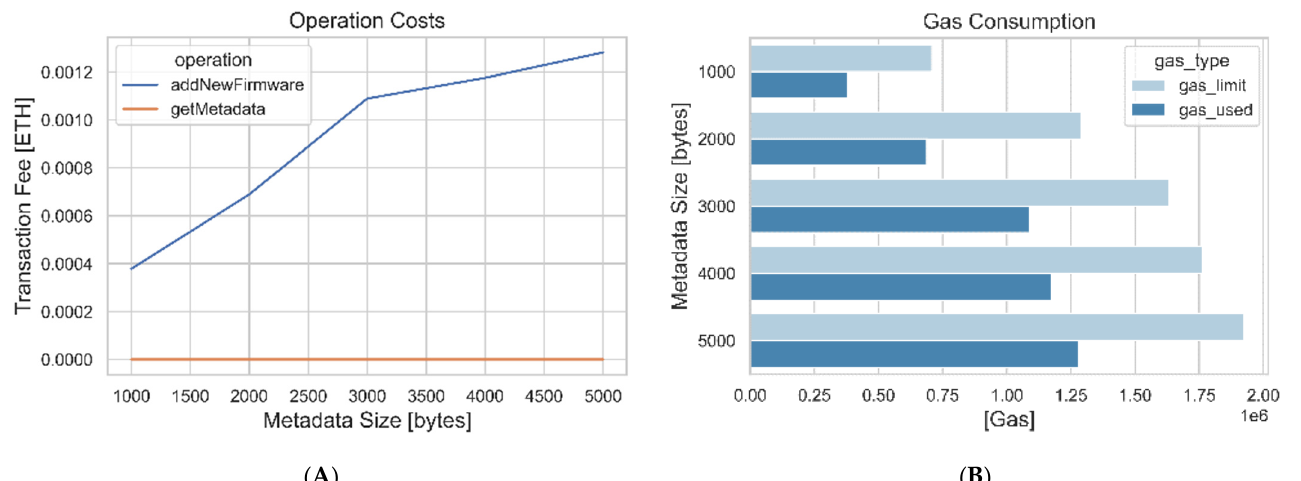
Figure 18. ( A ) Gas Price in ether. ( B ) Gas consumption of adding new firmware metadata on the Blockchain.